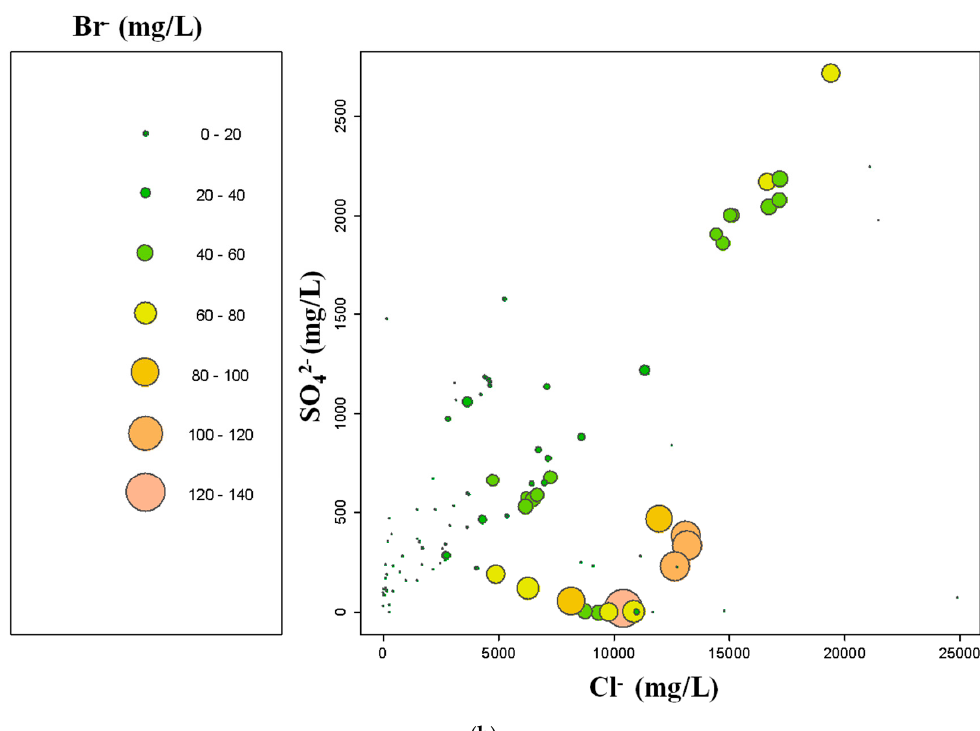
Figure 5. ( a ) Binary plot of Br − vs Cl − concentrations of all samples grouped by environments (1–8); ( b ) Binary plot of SO 42 − vs Cl − ; symbols are proportional to Br − concentrations. Using the diagram’s Cl − /Br − molar ratio vs the Cl − mg/L proposed by Alcalá and Custodio [22] as